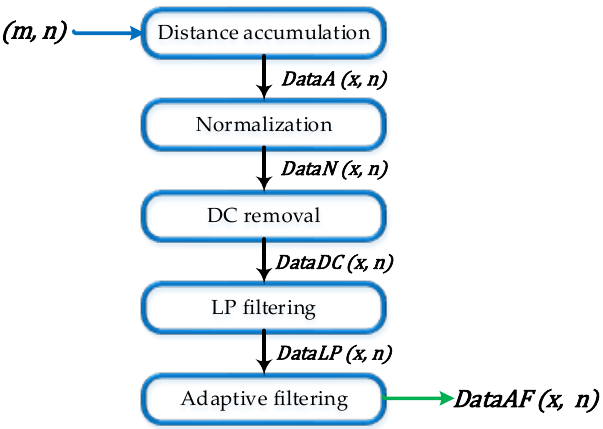
Figure 3. Flow chart of the preprocessing steps. Abbreviations: DC, direct current; LP, low ‐ pass.